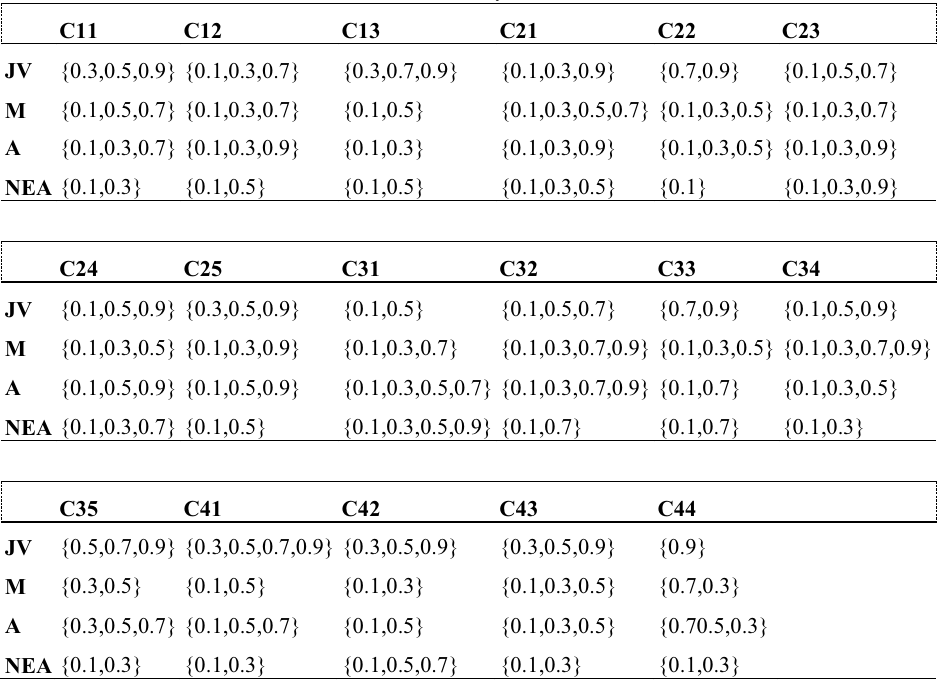
Table 15: Hesitant Fuzzy Decision